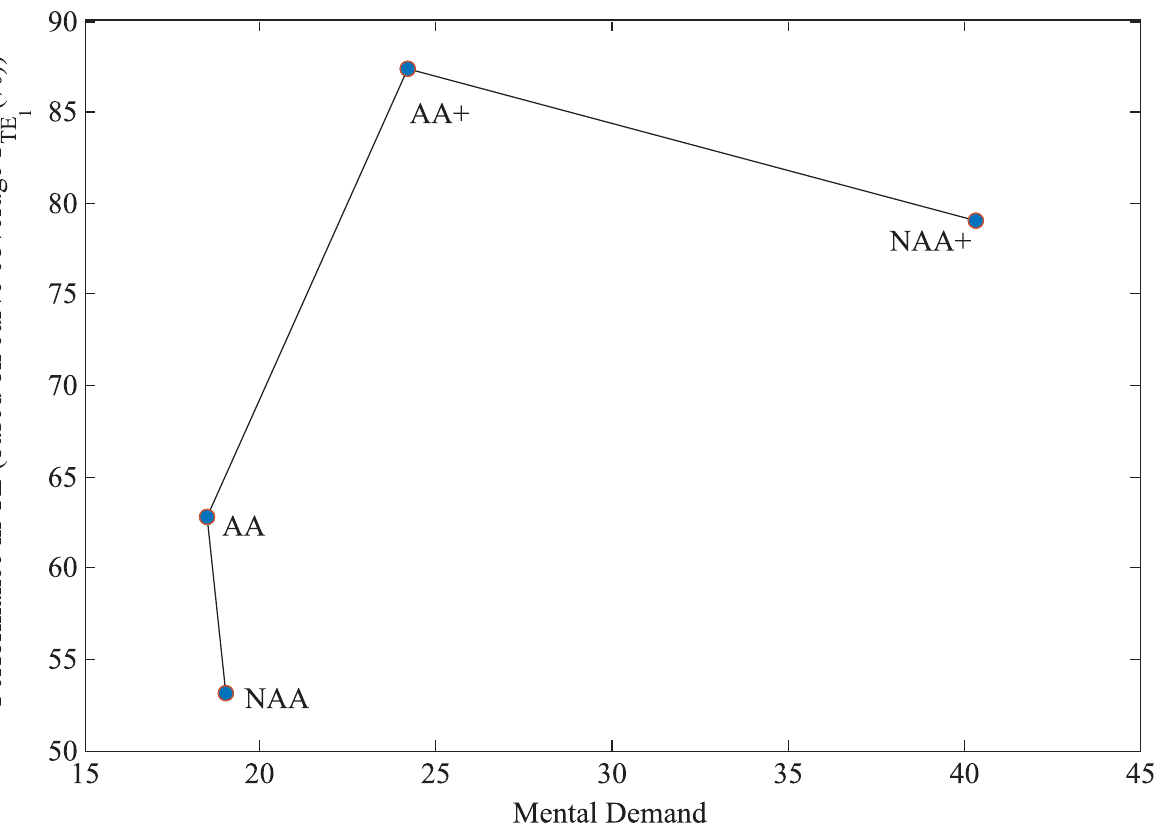
Fig 8. Average Mental Demand vs. Performance graph for TE based on NASA – TLX. Performance of subjects in TE experiments based on curve coverage versus mental demand as measured by NASA – TLX, where error bars represent the standard error. See Fig 6 for significance of this performance